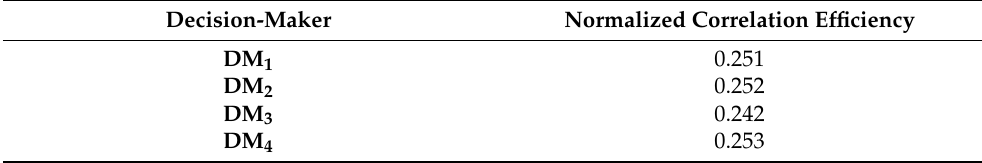
Table 6. Normalized correlation efficiency of